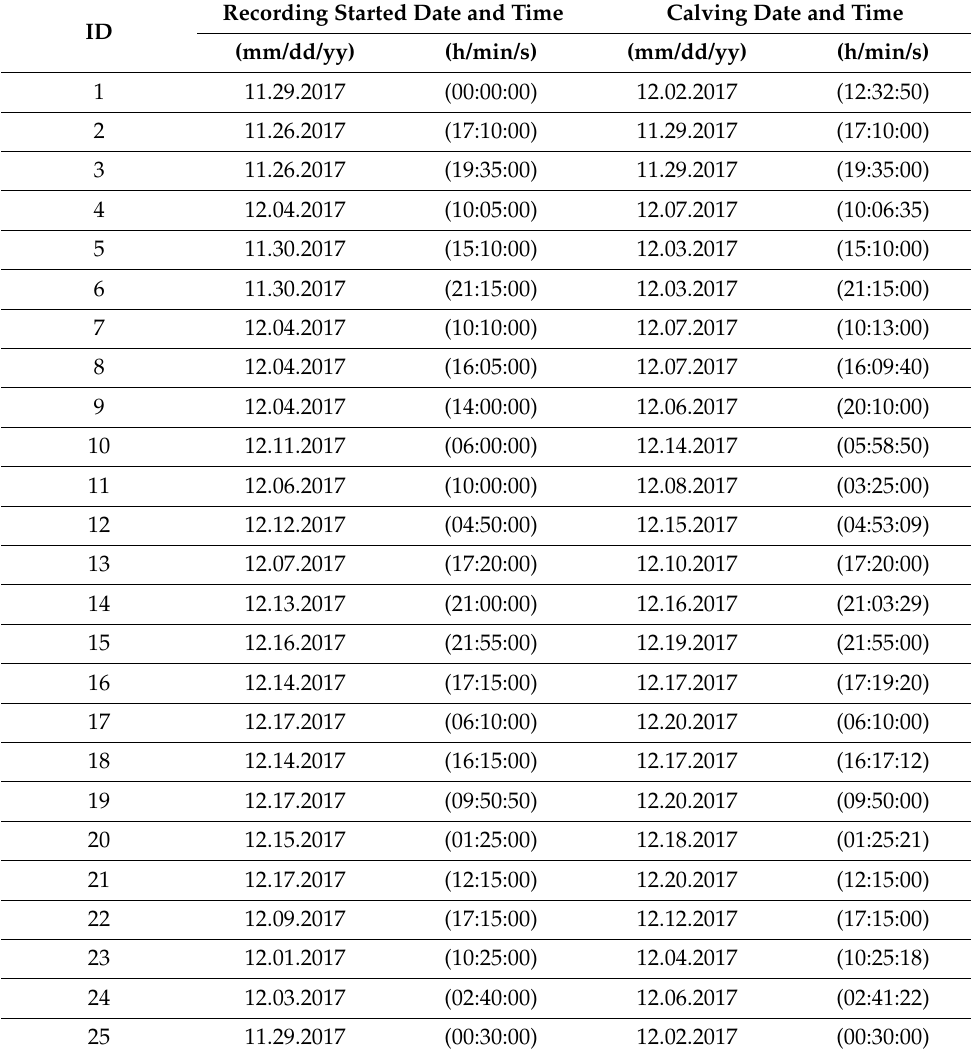
Table 1. Calving data information for 25 pregnant